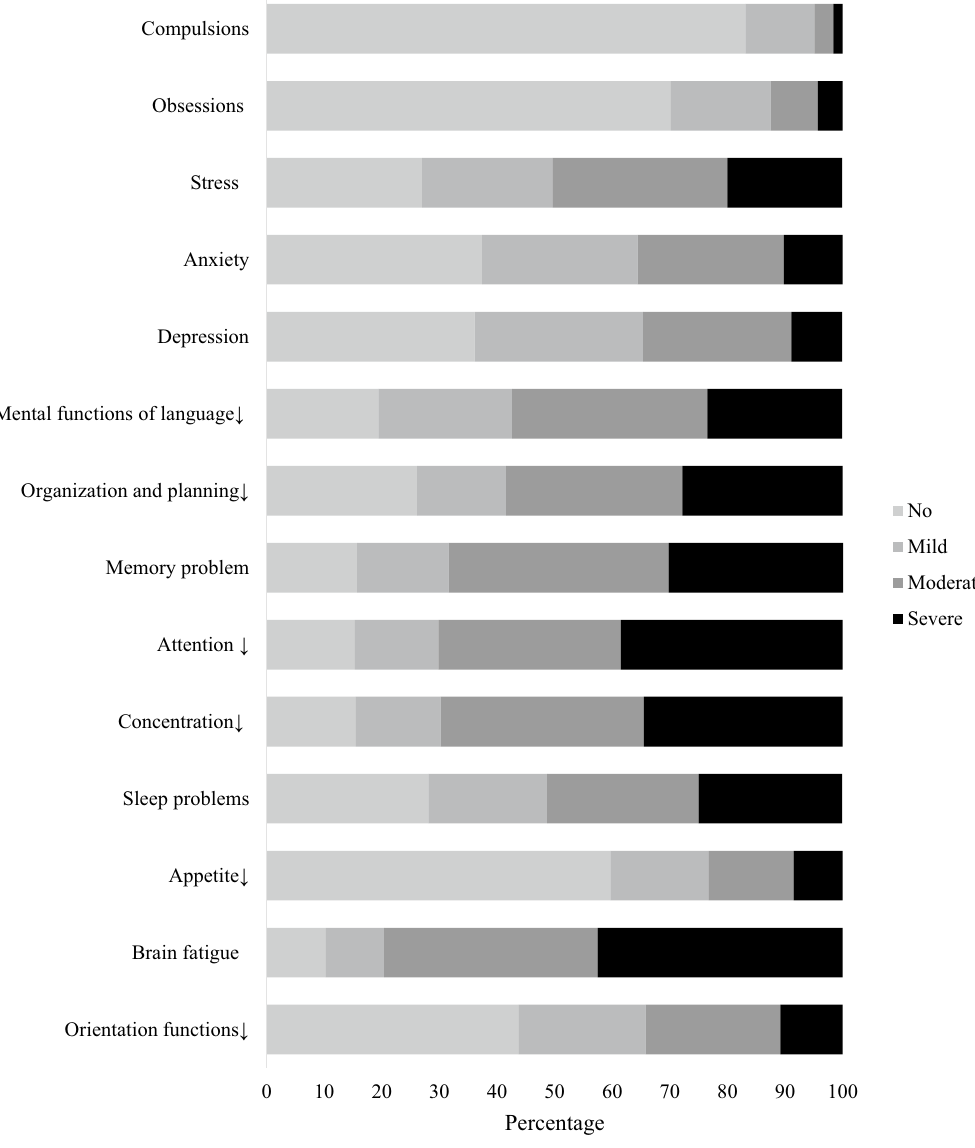
Figure 1. Proportions reporting impairments in mental